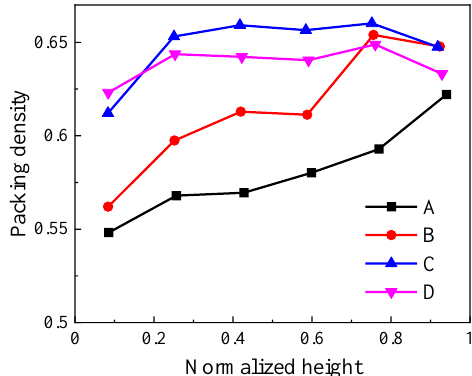
Fig. 5 Density variations with compact height for compacts A - D.